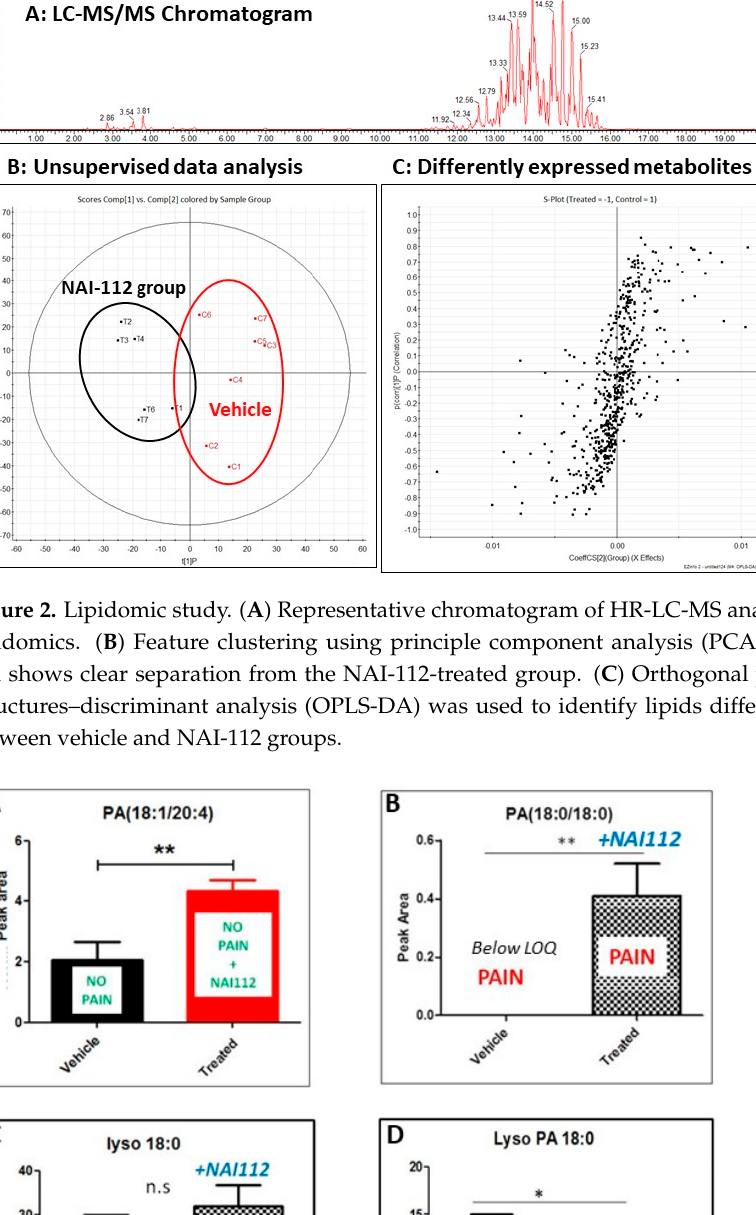
Figure 3. Effect on levels of phosphatidic acid (PA) and lysophosphatidic acid (Lyso PA or LPA). The levels of PA (18:1/20:4) and PA (18:0/18:0) increased by NAI ‐ 112 treatment in both naive and in ‐ pain mice ( A , B ). No significant effects were observed on LPA levels in no ‐ pain mice ( C ), while LPA (18:0) reduced after treatment with NAI ‐ 112 in in ‐ pain mice ( D ). In all panels, values are expressed as means ± SEM. The two ‐ tailed t ‐ test was used to assess statistical significance: * p < 0.05; ** p < 0.01; n.s., not significant.